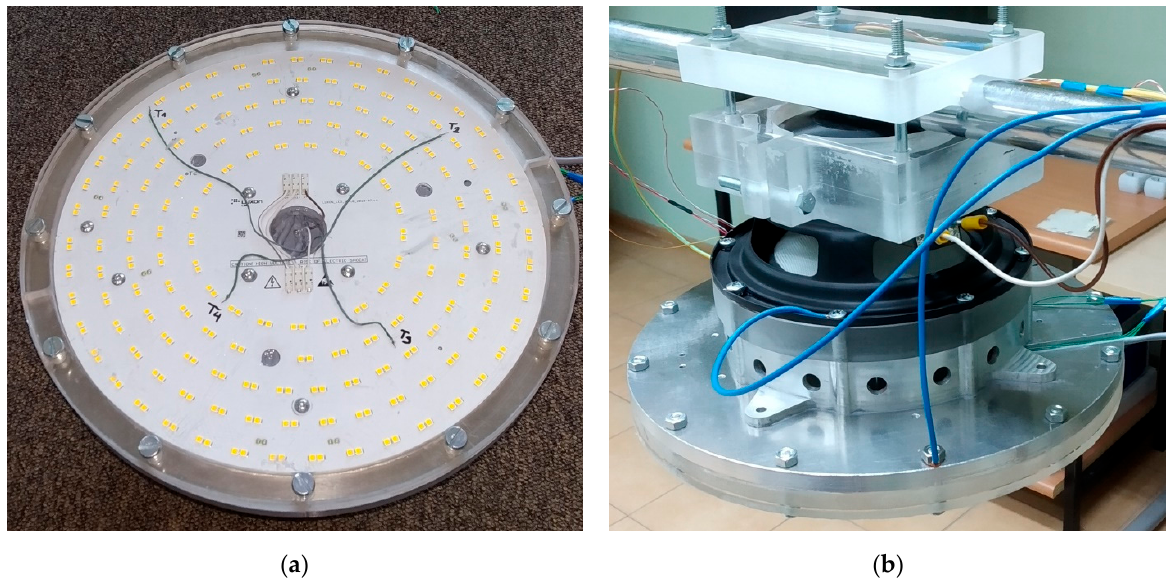
Figure 2. ( a ) The LED lamp PCB and transparent PMMA plate. ( b ) The assembled LED